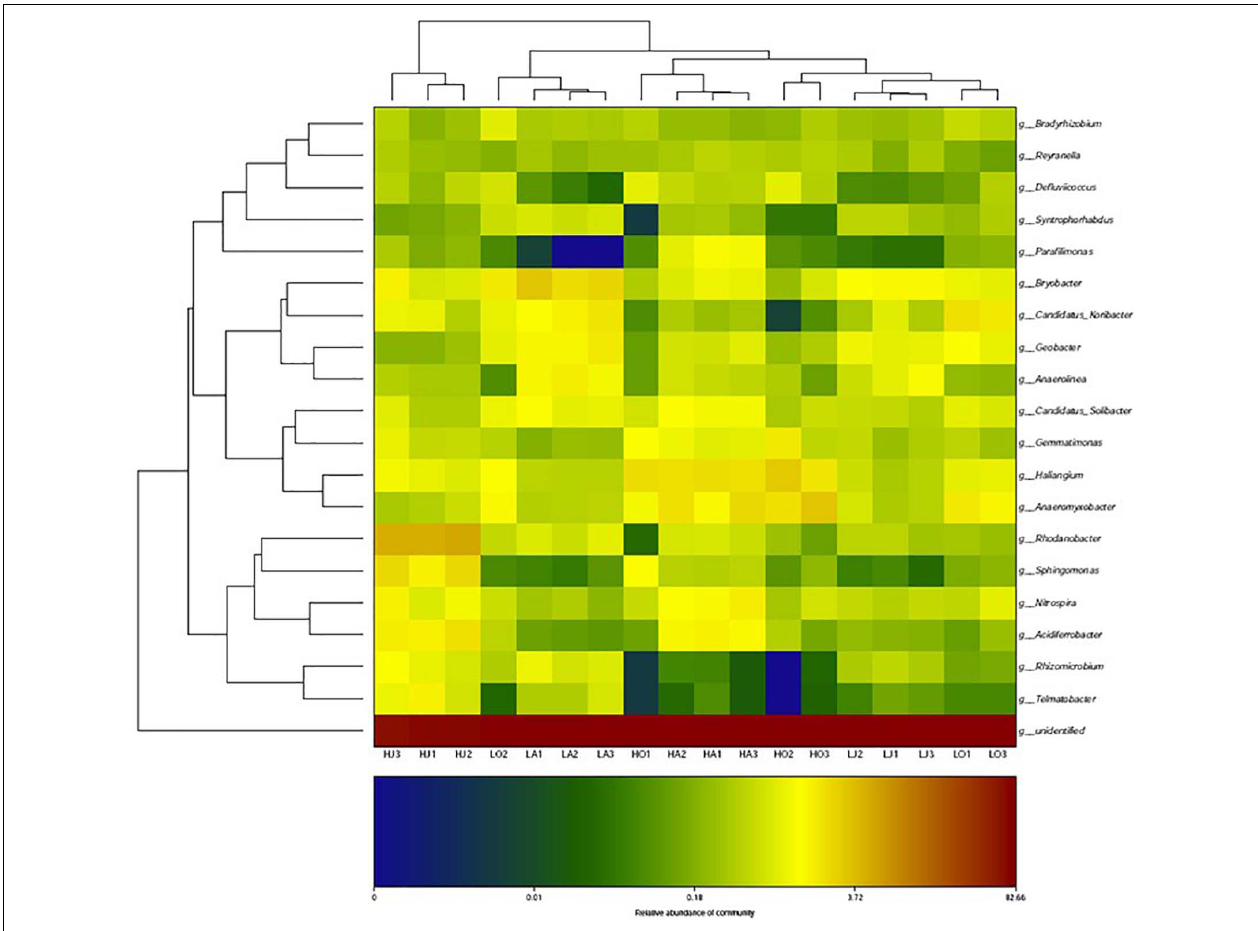
FIGURE 3 | Heatmap of the cluster analysis for top-20 most abundant bacteria at genus-level for the six samples of different Cd concentrations (LA: 0.46 mg/kg; LJ: 0.36 mg/kg; LO: 0.39 mg/kg; HA: 27.11 mg/kg; HJ: 53.70 mg/kg; HO: 8.52